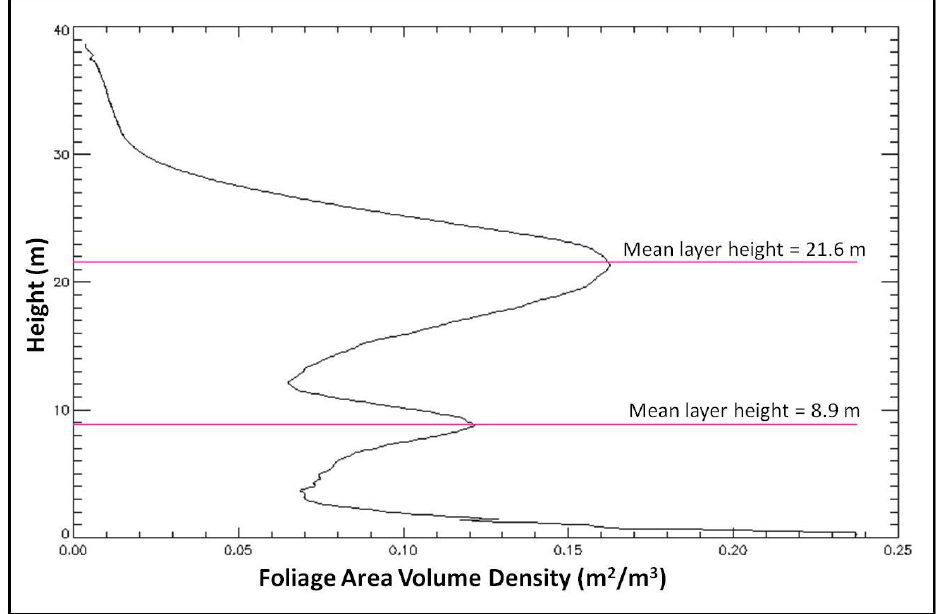
Figure 4. Example of layers from foliage profile